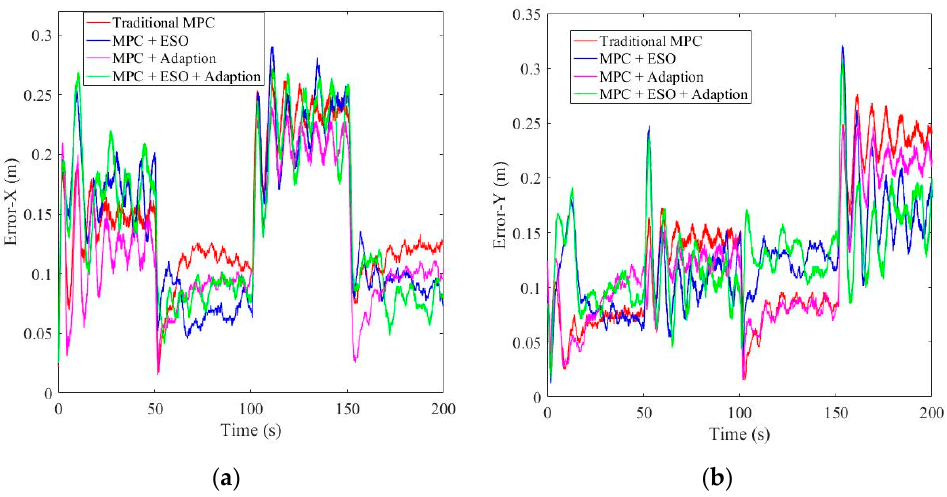
Figure 14. The position error of the robot at the disturbance velocities u = 0.1 m/s and v = 0.1 m/s. ( a ) The trajectory error in the X direction; ( b ) The trajectory error in the Y direction.